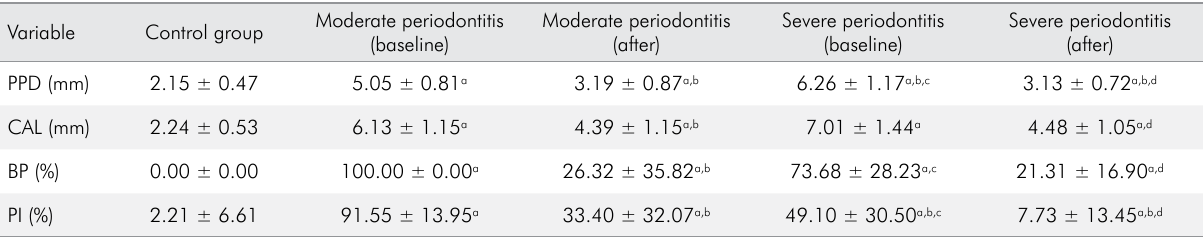
Table 4. Mean and standard deviation of clinical periodontal parameters of the periodontal sample sites from the control and the chronic periodontitis groups at baseline and after nonsurgical periodontal